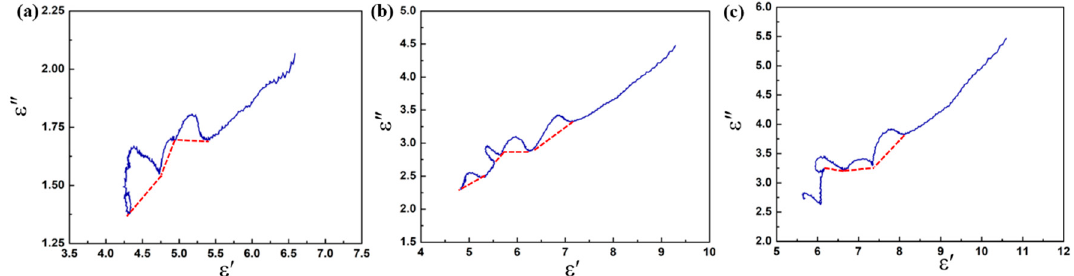
Figure 8. Cole–Cole plots of ( a ) S1, ( b ) S2, and ( c ) S3.